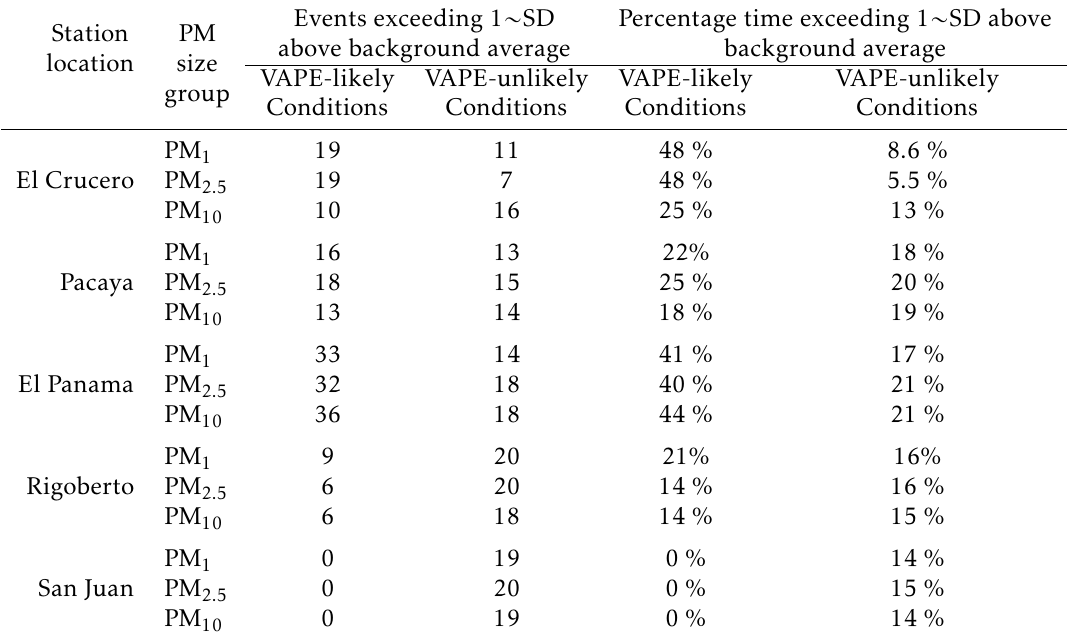
Table 3: PM pollution events defined as a period of 24-hours exceeding 1 standard deviation (SD) above the monthly background 24-hour PM average. VAPE-likely and VAPE-unlikely conditions are determined from ECMWF data and satellite imagery, and the monthly background average concentration is calculated from the VAPE- unlikely period data. The percentage of time exceeding the background average is calculated from the total time under VAPE-likely or VAPE-unlikely